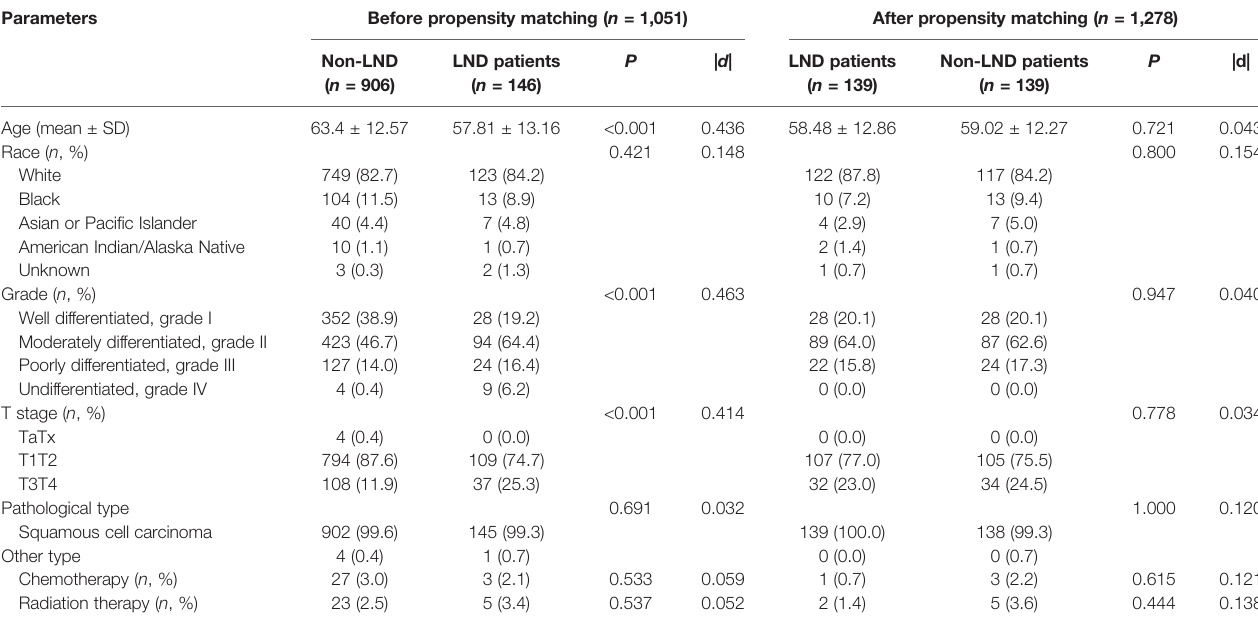
TABLE 4 | Comparison of clinical patient characteristics between LND and non-LND groups before and after propensity score matching. Parameters Before propensity matching ( n = 1,051) After propensity matching ( n =